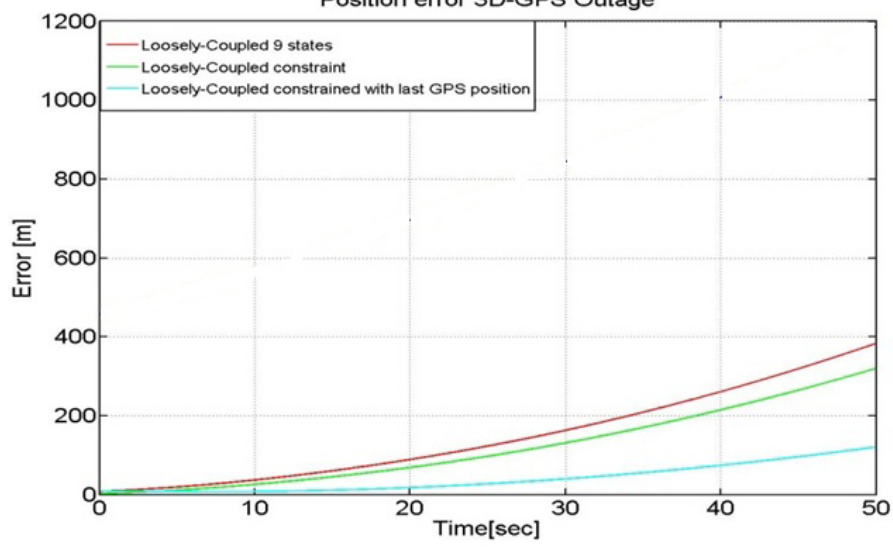
Figure 14. LC in case of GPS outage with weigthening of the last available GPS